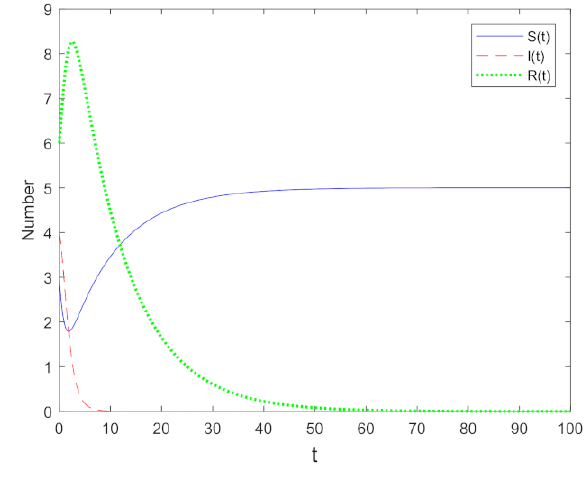
Figure 2. The stability of the equilibrium point E 1 .